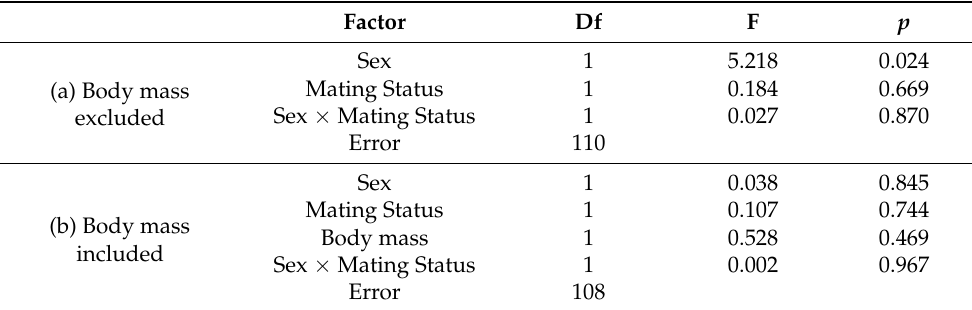
Table 1. The results of two general linear models of preferred temperatures of Callosobruchus macula- tus beetles, without and with body mass as a covariate. Mating status represents either nonmated beetles (virgin individuals) or mated beetles (virgin individuals that were allowed to mate once).